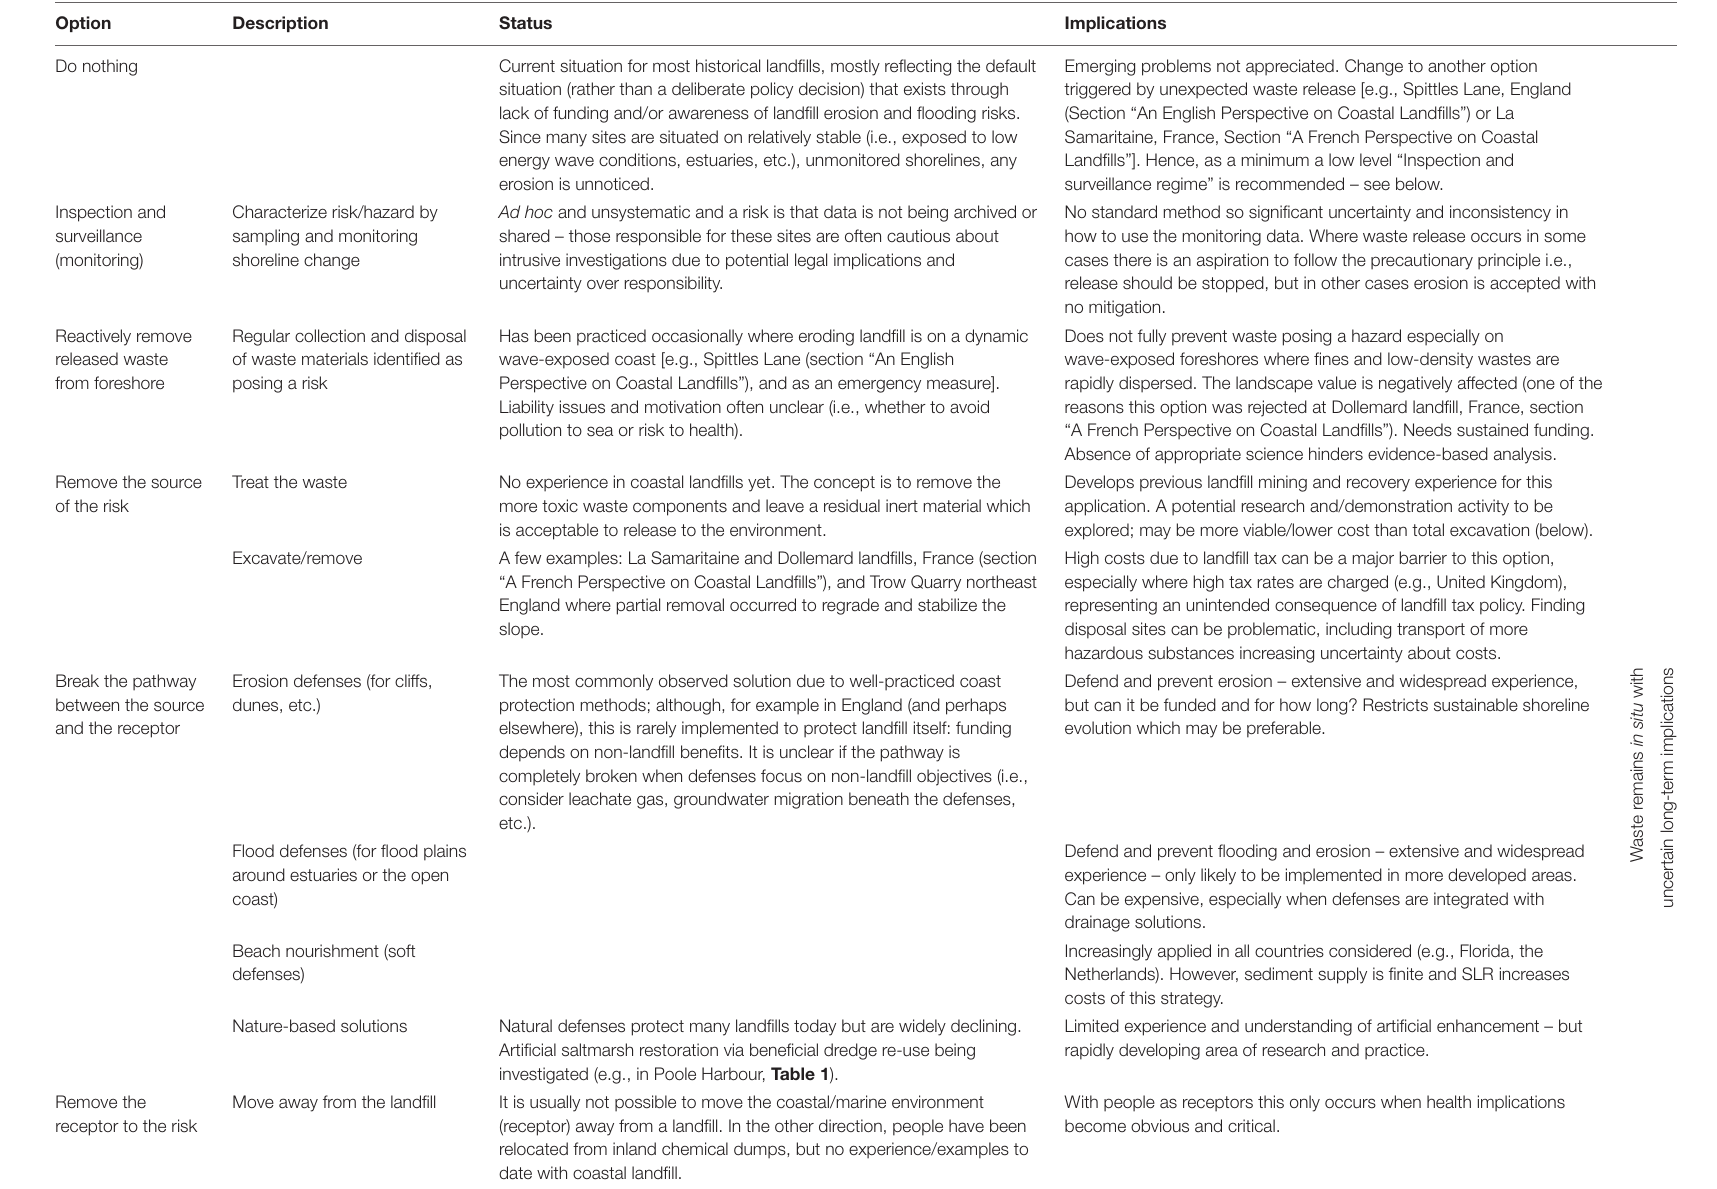
TABLE 5 | Summary of potential historical coastal landfill management options from this analysis, using the source-pathway-receptor terminology for pollution risk (see also Cooper et al., 2013; Wadey et al., 2019).